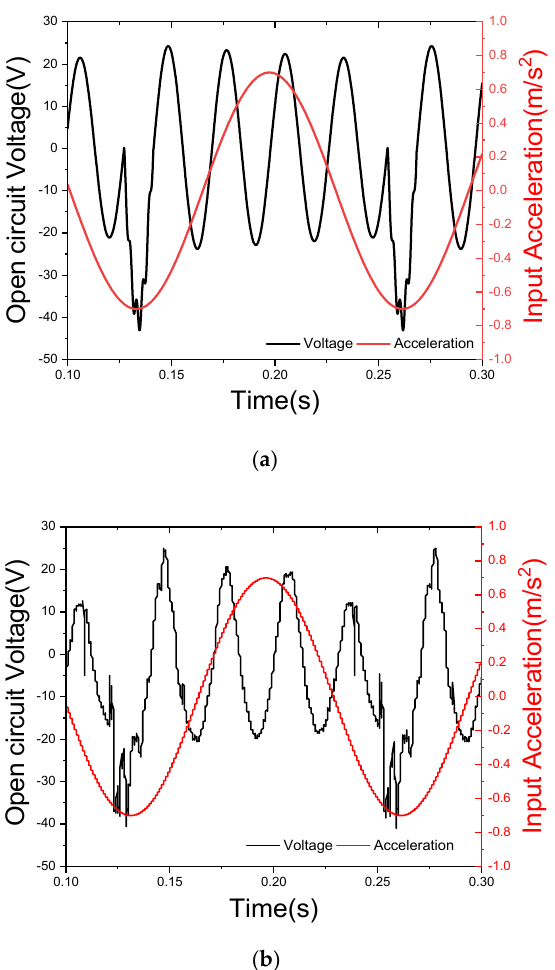
Figure 6. ( a ) The calculated open circuit voltage waveform and ( b ) the measured instantaneous voltage waveform.